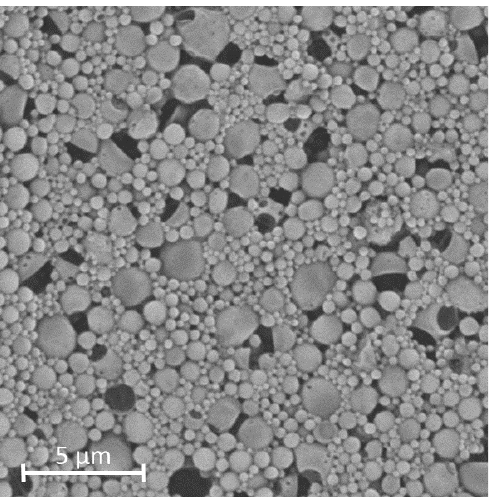
Figure 5. Verification of z-average ( a ), PDI ( b ), LE ( c ) and LC ( d ) of the product in triplicate and the 95 % confidence interval (CI) and 95 % prediction interval (PI).